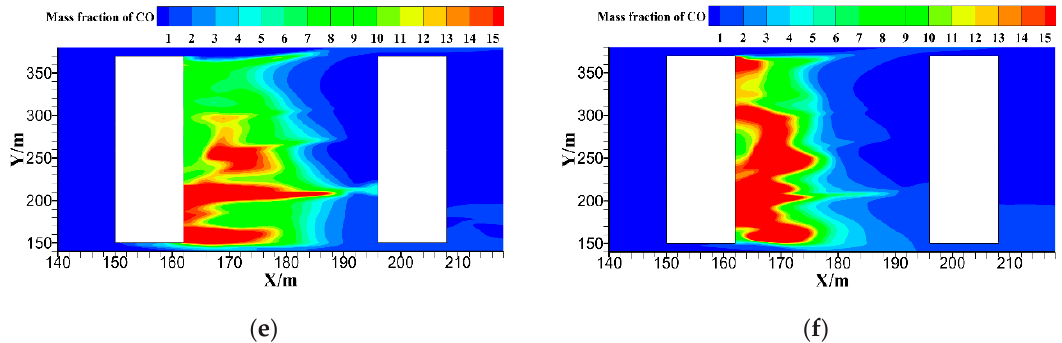
Figure 6. CO concentration field profiles (10 − 9 ) in the street space for different pollution source distributions under a wind speed of 3 m/s. ( a ) R = 1/2; ( b ) R = 2; ( c ) R = 1/3; ( d ) R = 3; ( e ) R = 1/5; ( f ) R = 5.